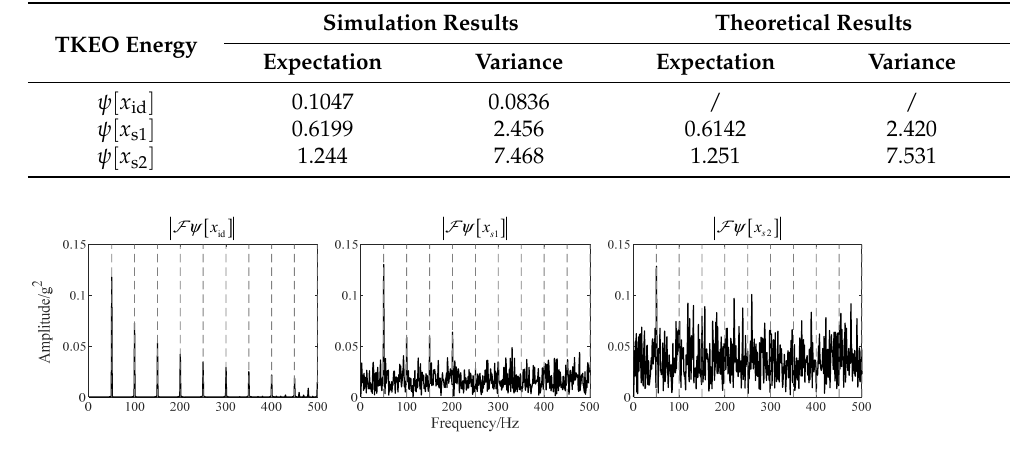
id , x s1 and x s2